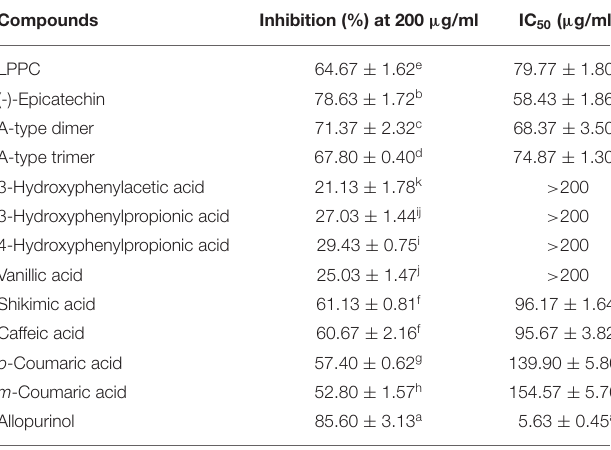
TABLE 2 | Xanthine oxidase inhibitory properties of LPPC and its